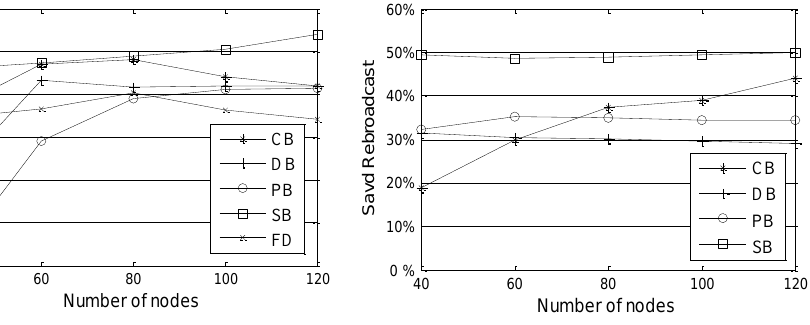
Fig. 1. Comparison of reachability. Fig. 2. Comparison of saved rebroadcast.